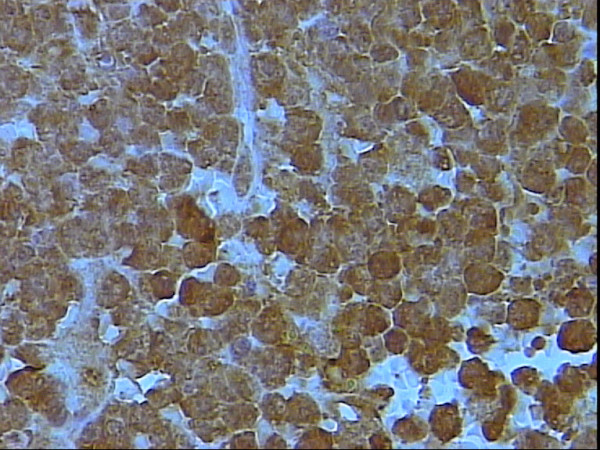
Higher power magnification of figure 6 showing moderate to strong nuclear for s100p, DAB, Hx, × 40.